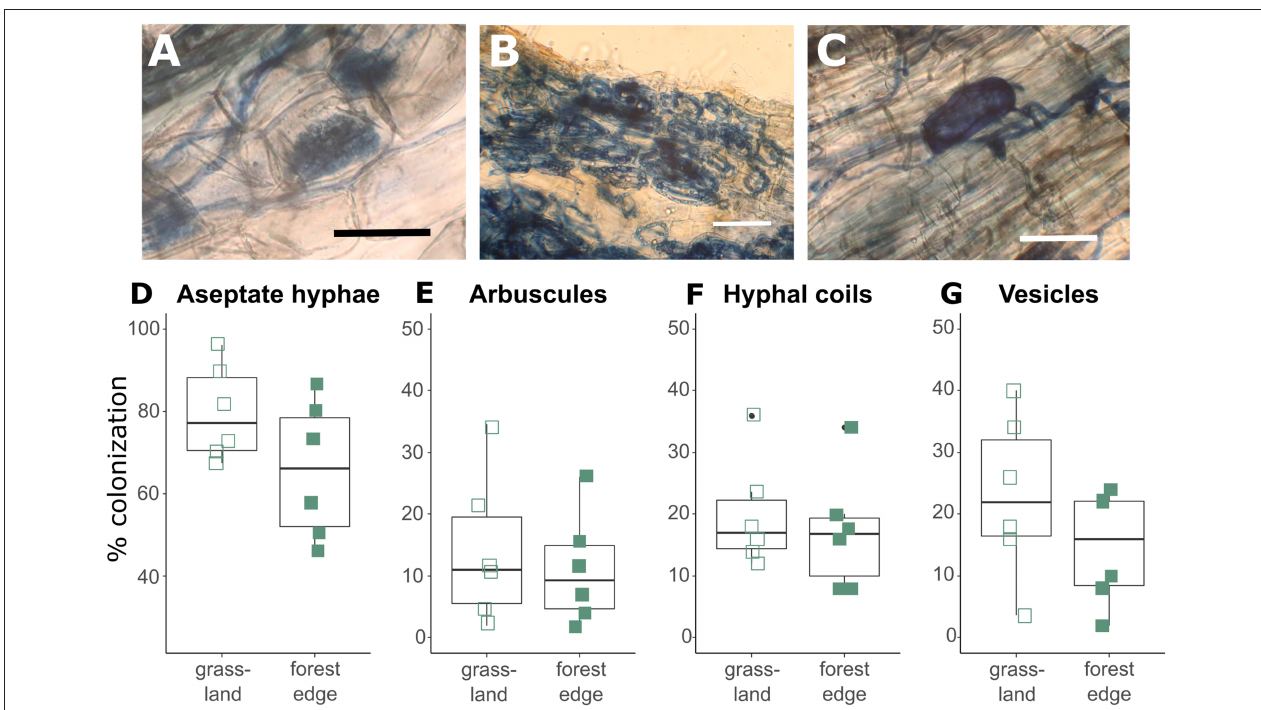
FIGURE 1 | Arbuscular mycorrhizal structures found in the roots of Crataegus monogyna included aseptate hyphae, arbuscules (A) , hyphal coils (B) and vesicles (C) . Hyphal colonization rates (D) were significantly higher (GLMM: z = − 2.239, p = 0.025) and arbuscular colonization rates (E) tended to be higher (GLMM: z = − 1.774, p = 0.076) in root samples from grassland than from the forest edge. No significant difference was found in root colonization levels by hyphal coils (F) and vesicles (G) between root samples from grassland and from forest edge. Scale bar: 50 µ